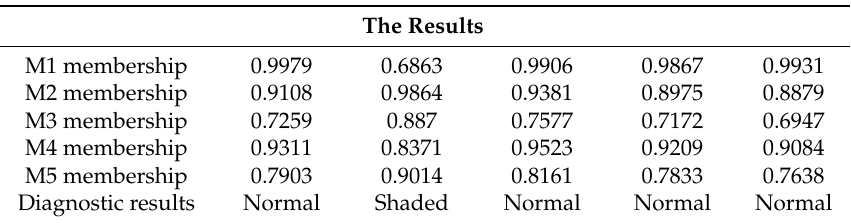
Table 9. The dynamic adaptability analysis of the algorithm.